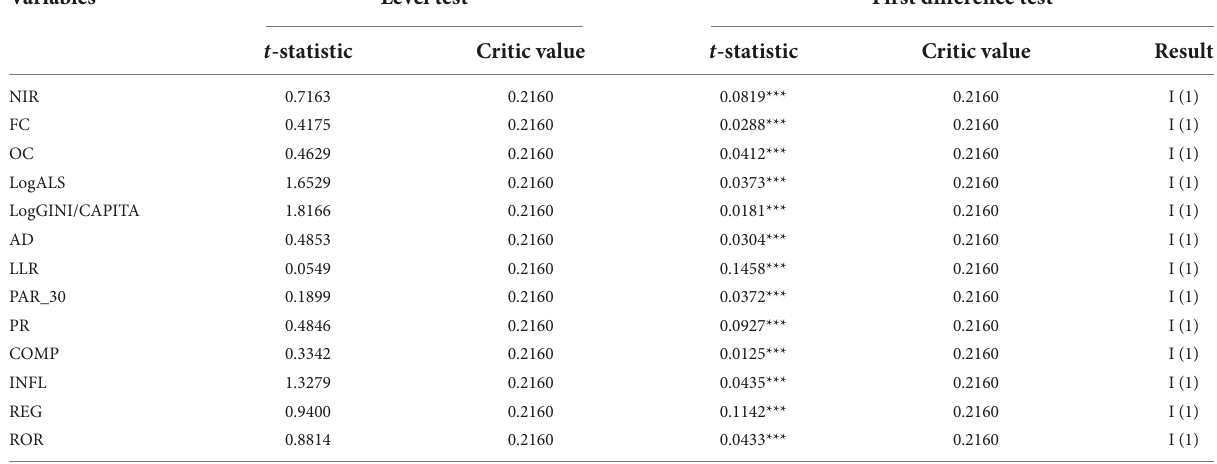
TABLE 2 Table of the unit root